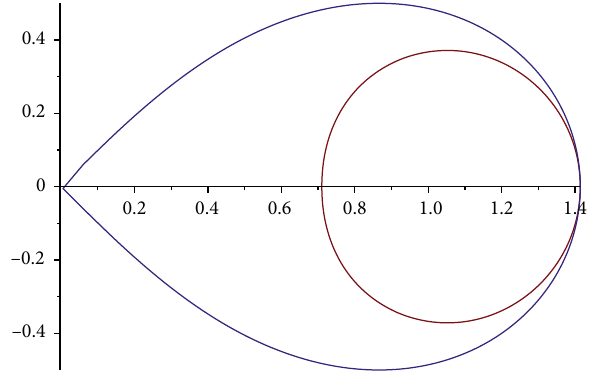
Figure 5: The image of ∣ z ∣ = 1 under q ð z Þð s = 1/ ⋯ Þ and